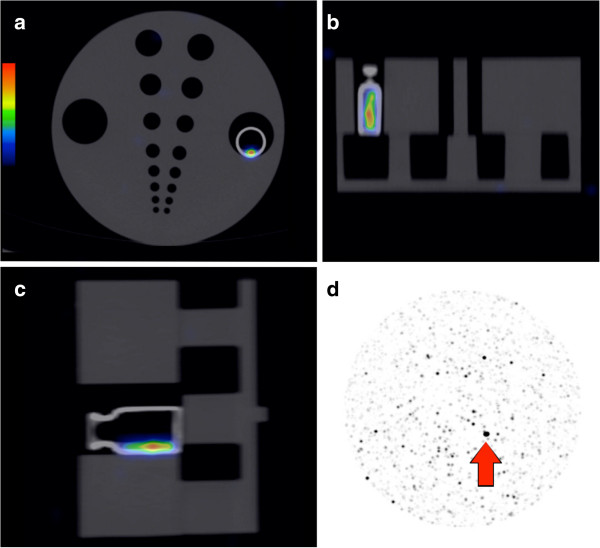
Example of a 90Y PET/CT phantom scan with maximum intensity projection image. (a) Trans-axial, (b) coronal, and (c) sagittal planes. This scan shows our lowest tested vial sediment activity of 3.5 MBq (≈3 MBq/ml). The upper PET visual display threshold of this scan was adjusted to 114% (2,000 kBq/ml) to minimize visual interference from background noise [1]. (d) Maximum intensity projection image of the same phantom scan (arrow indicates vial sediment) with the upper PET visual display threshold adjusted to 1% (20 kBq/ml) to reveal the underlying background noise as an example to readers [1].